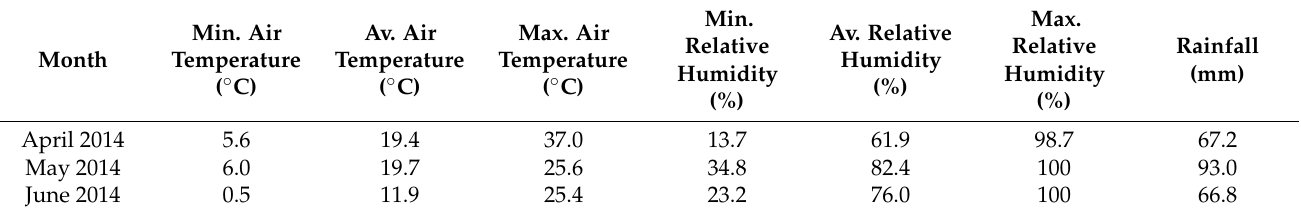
Table 1. The actual rainfall, air temperature and relative humidity data from April 2014 to June 2014 at the Dandaragan experimental